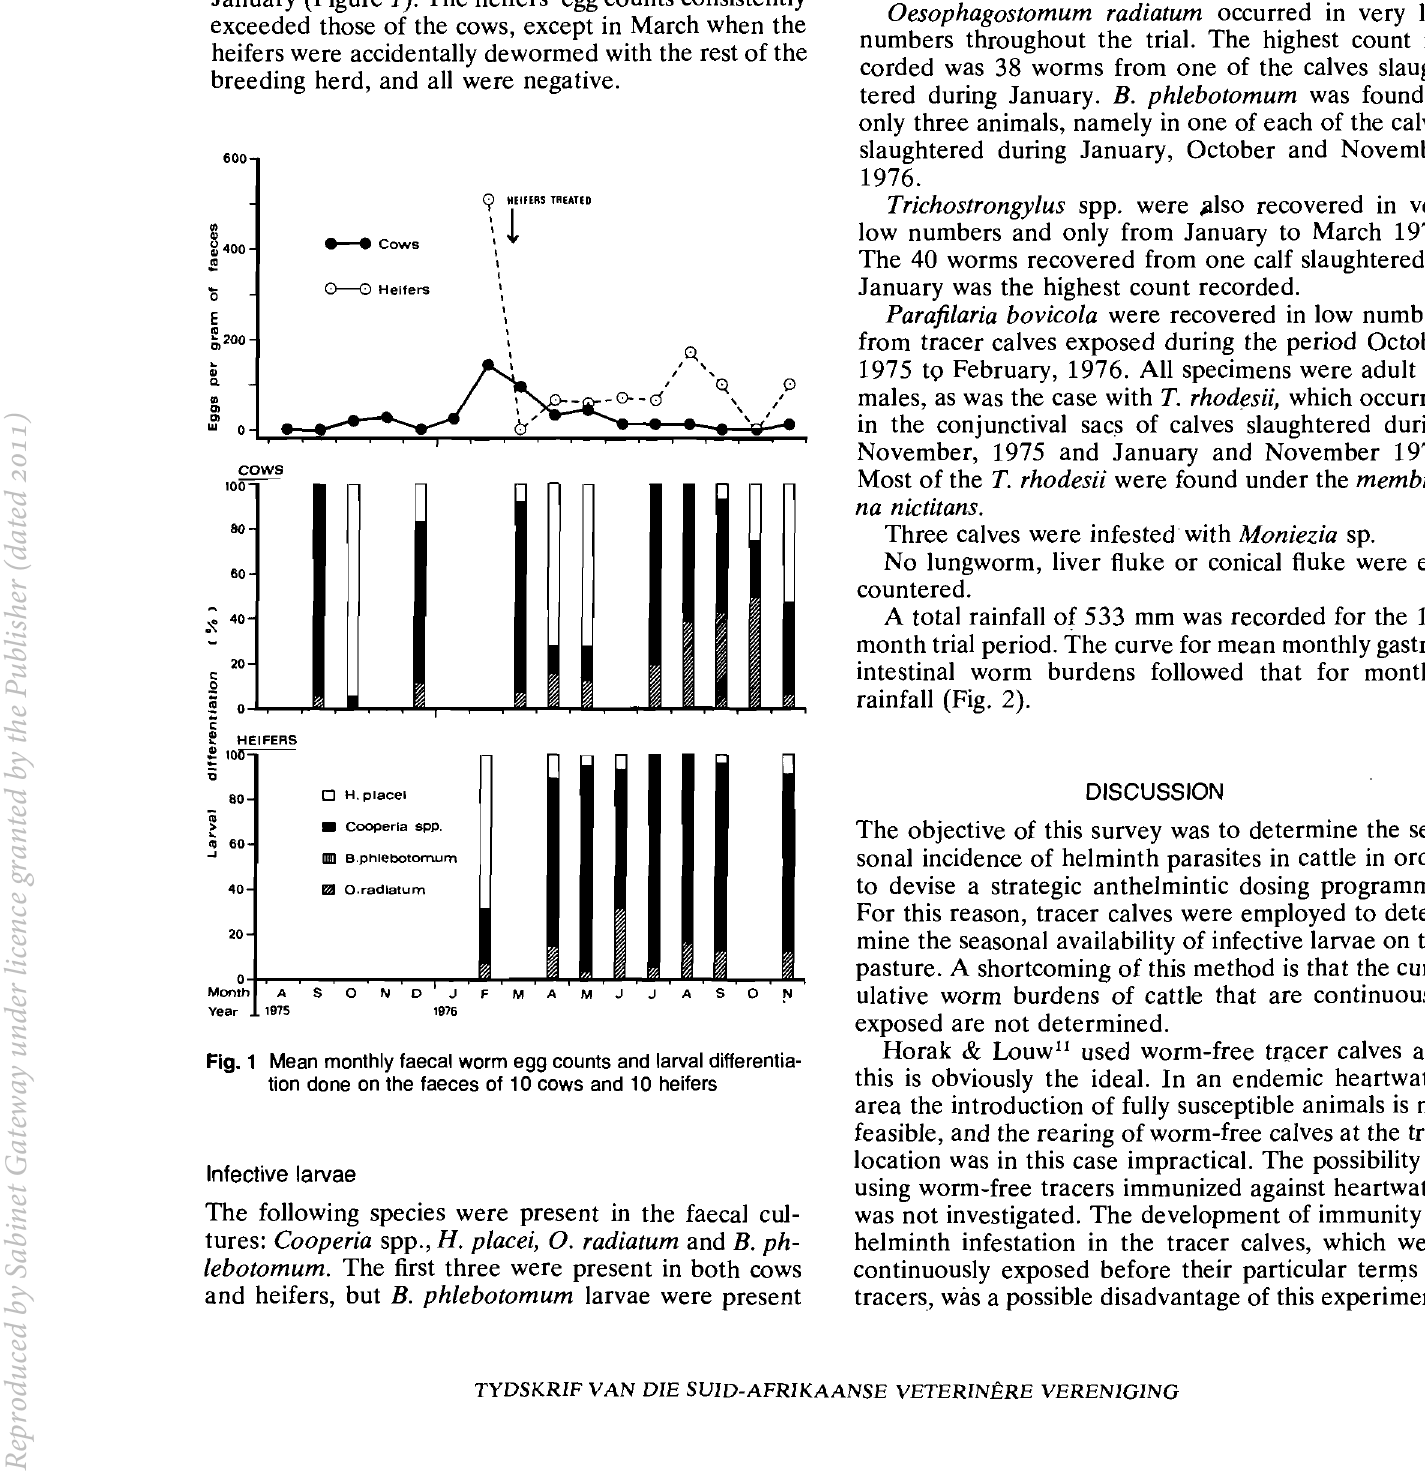
Fig. 1 Mean monthly faecal worm egg counts and larval differentia· tion done on the faeces of 10 cows and 10 heifers